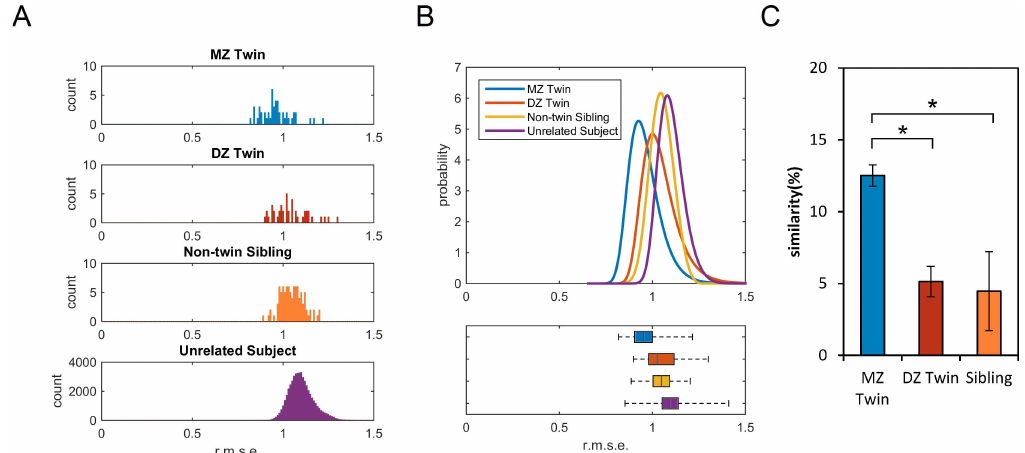
Fig 7. The differences and similarities between twins and siblings. (A) The histogramsshow the distribution of the root-mean-square-error (r.m.s.e) betweenMZ twins, DZ twins, non-twinsiblings,and genetically unrelatedsubjects calculated from their local connectome fingerprints.On average, MZ twins havethe lowest differencebetweeneach twin pair, followedby DZ twins andsiblings.(B) The upper figure shows the differencesfitted with generalizedextreme valuedistribution. The lower figureshows the box plot of the distribution to facilitate comparison. The four distributions are mostly overlapping, indicatingthat twins and siblings still havehigh individualitysimilar to genetically-unrelated subjects.(C) The similaritybetweenMZ twins is significantly higherthan that betweenDZ twins or non-twinsiblings, whereasthe similaritybetweenDZ twins is not statistically differentfrom the similaritybetweennon-twinsiblings.